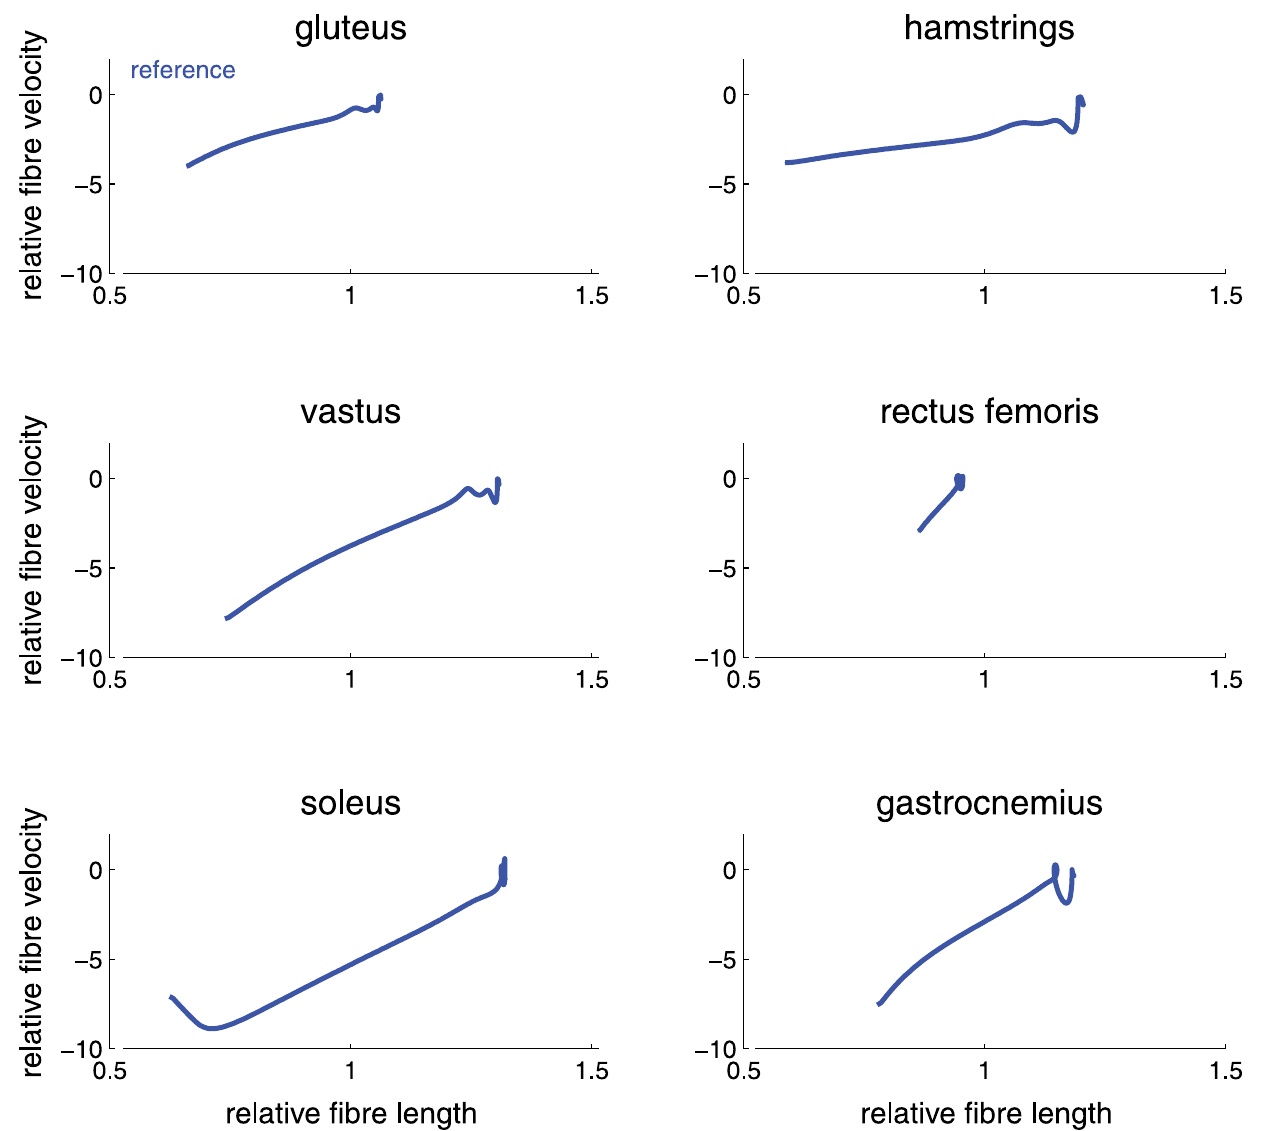
Fig 5. Optimum fiber lengths per second s − 1 and relative muscle length for the reference model muscles. Muscles begin at relatively long length and shorten during push-off. Note that relative muscle length of the gluteus is particularly short at the beginning of